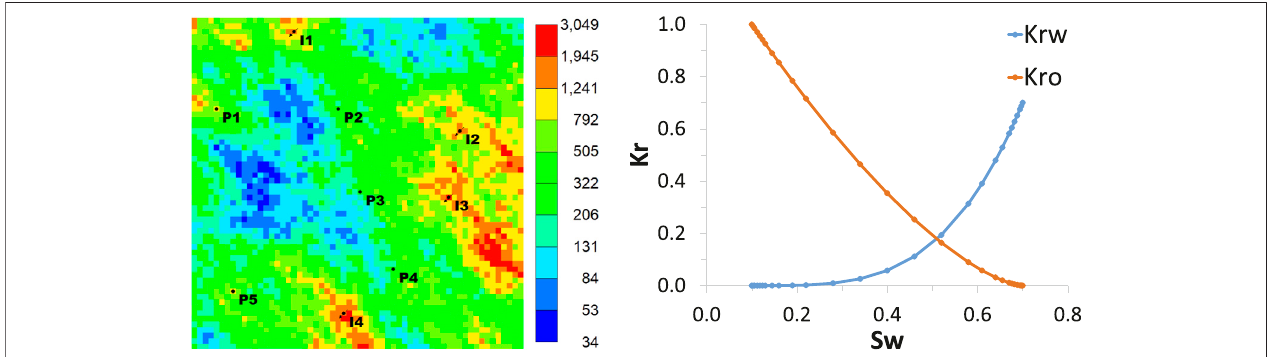
FIGURE 11 | Permeability map (mD) (left) and Relative permeability curves (right)